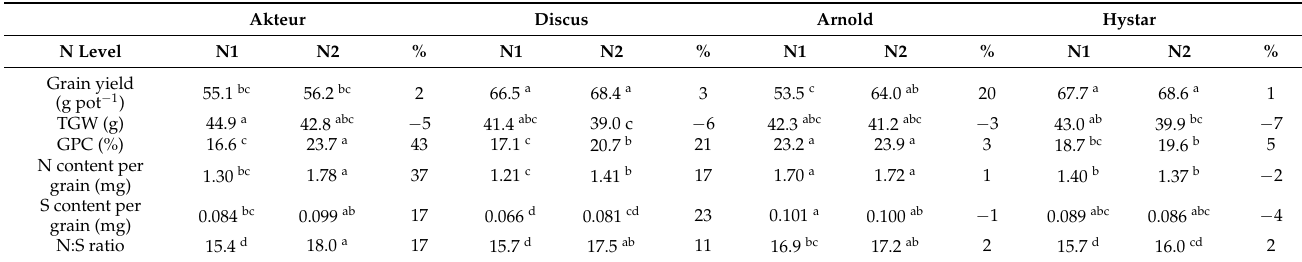
Table 3. Effect of excessive N supply (N2) and cultivar on grain yield, thousand grain weight (TGW), grain protein concentration (GPC), mean N and S content per grain, and N to S ratio (N:S) in four wheat cultivars. Means are presented. Different letters indicate significant differences ( p < 0.05).